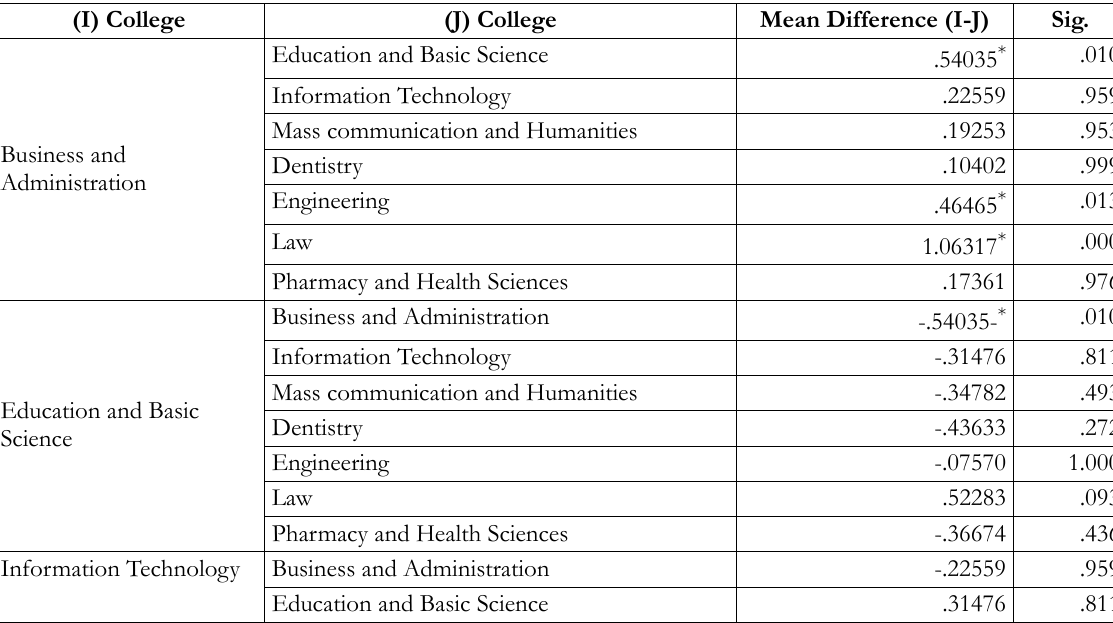
Table 9. One-way ANOVA of teachers’ responses, according to